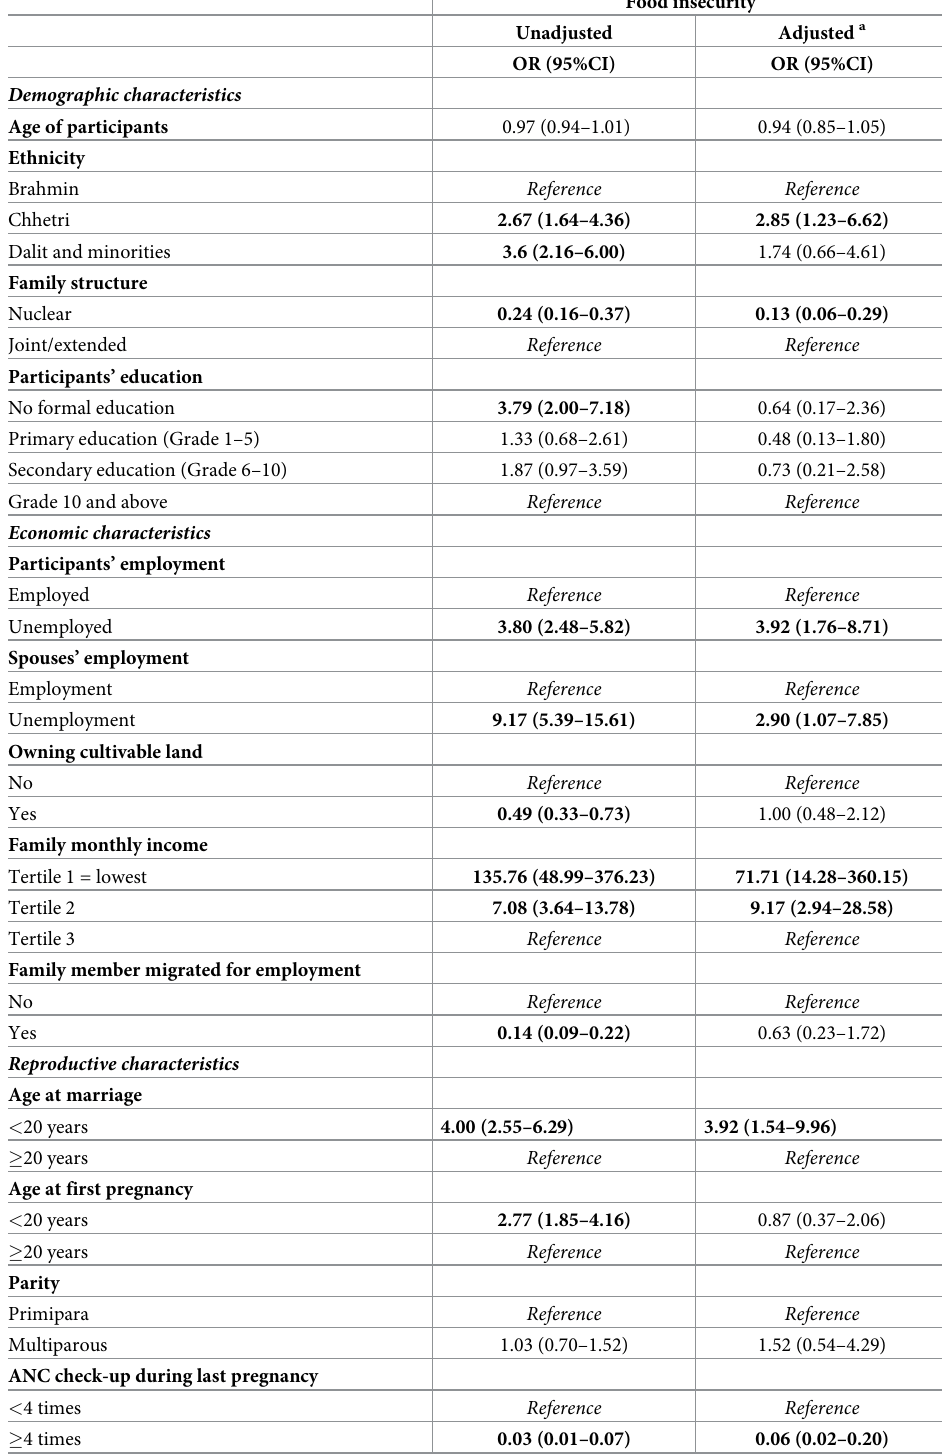
Table 2. Unadjusted and adjusted odds ratios using logistic regression for factors associated with food insecurity among lactating mothers in Jaya Prithivi Municipality, Bajhang District, Nepal (n =